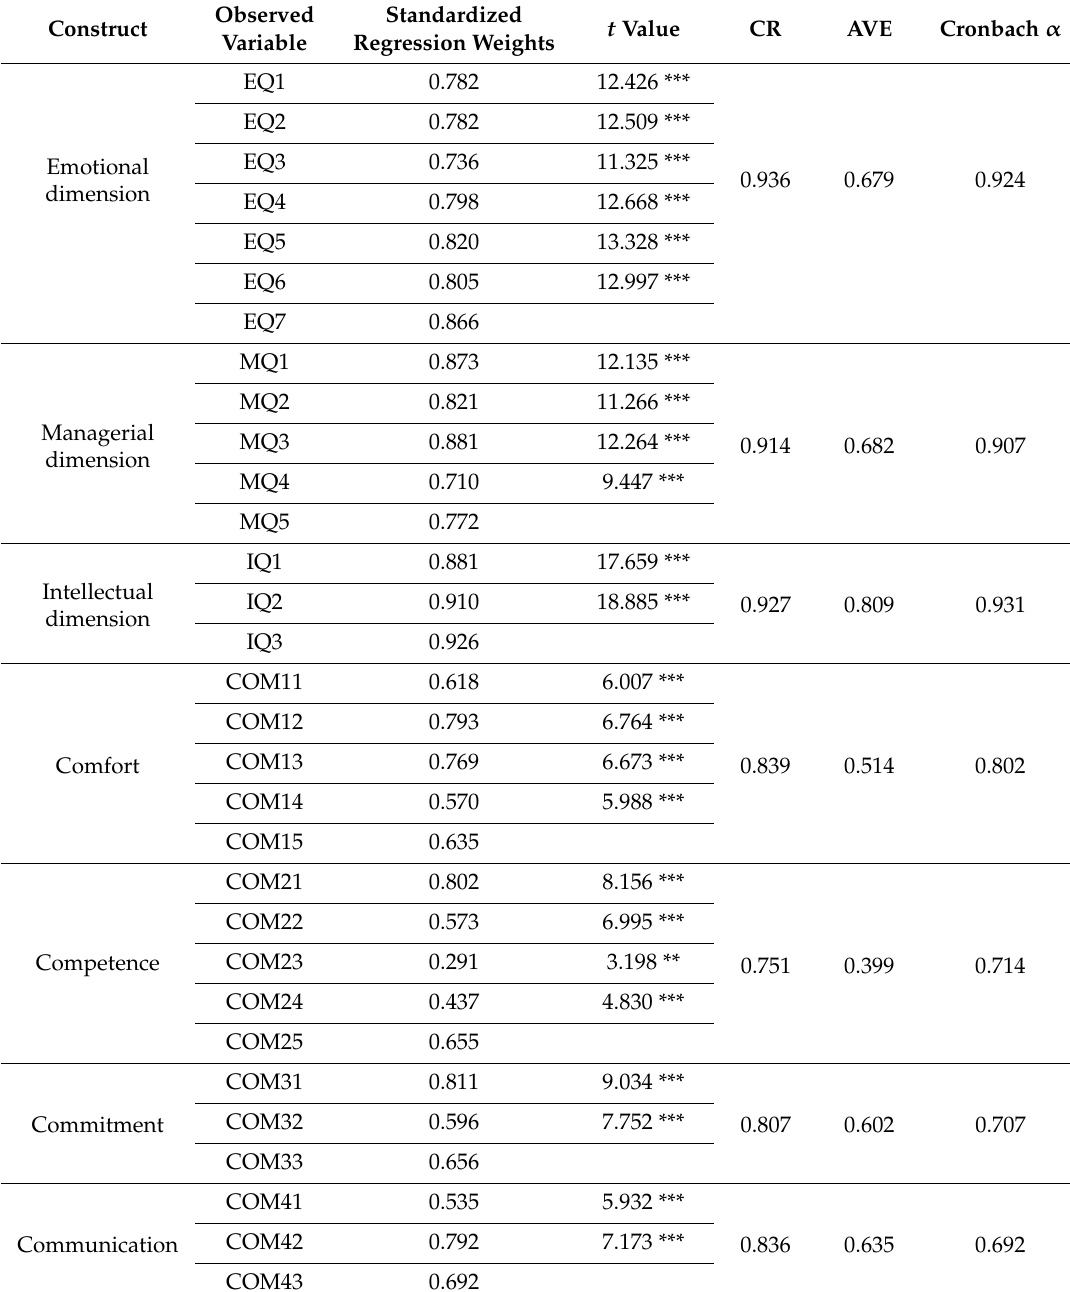
Table 4. Results of reliability and validity